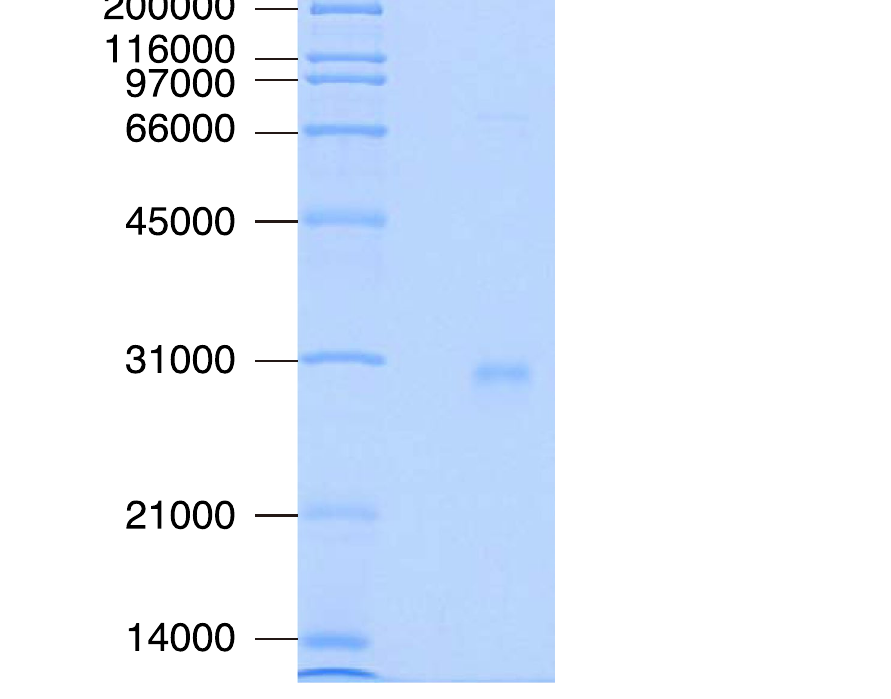
Figure 1. SDS-PAGE analysis of HNL purified from N. tambanus tambanus . HNL purified from N. tambanus tambanus was separated by 12% SDS-PAGE with Broad Range (Bio-Rad Laboratories) molecular weight markers. The full-length gel is presented in Fig.